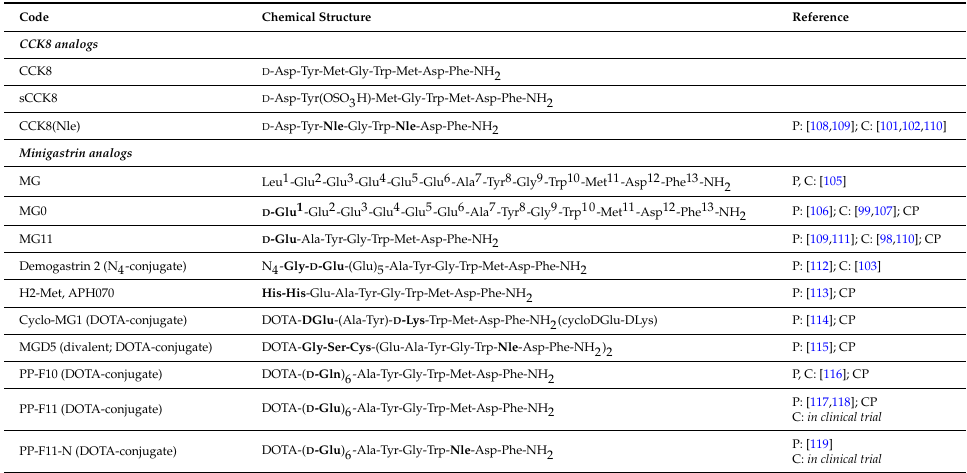
Table 2. Cholecystokinin 8 (CCK8) and minigastrin analogs and conjugates.